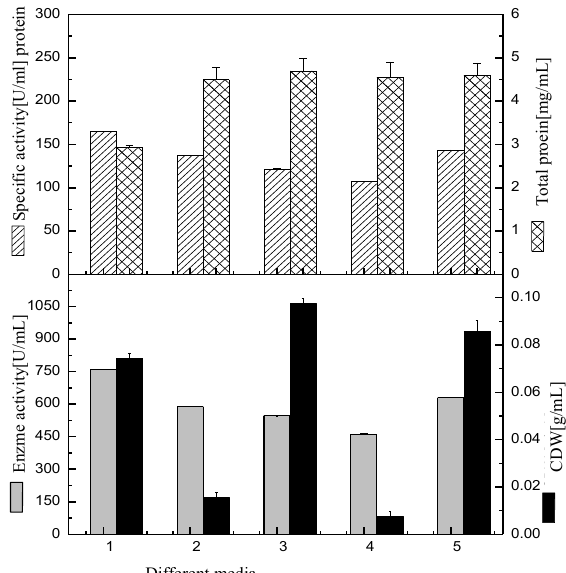
Figure 2. Media screening for proteases production by Str. pseudogrisiolus NRC-15 at shake flask on 200 rpm at 96